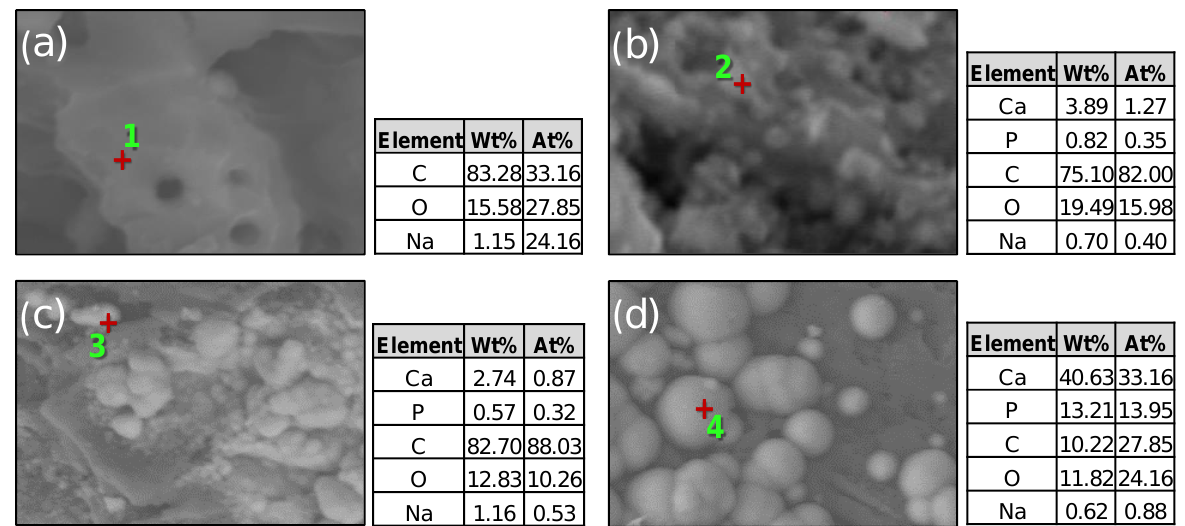
Figure 7. EDS analysis of carbon and HAp-modified carbon materials; ( a ) AC, ( b ) AC-HAp, ( c ) AC-1hHAp, and ( d ) AC-2hHAp.